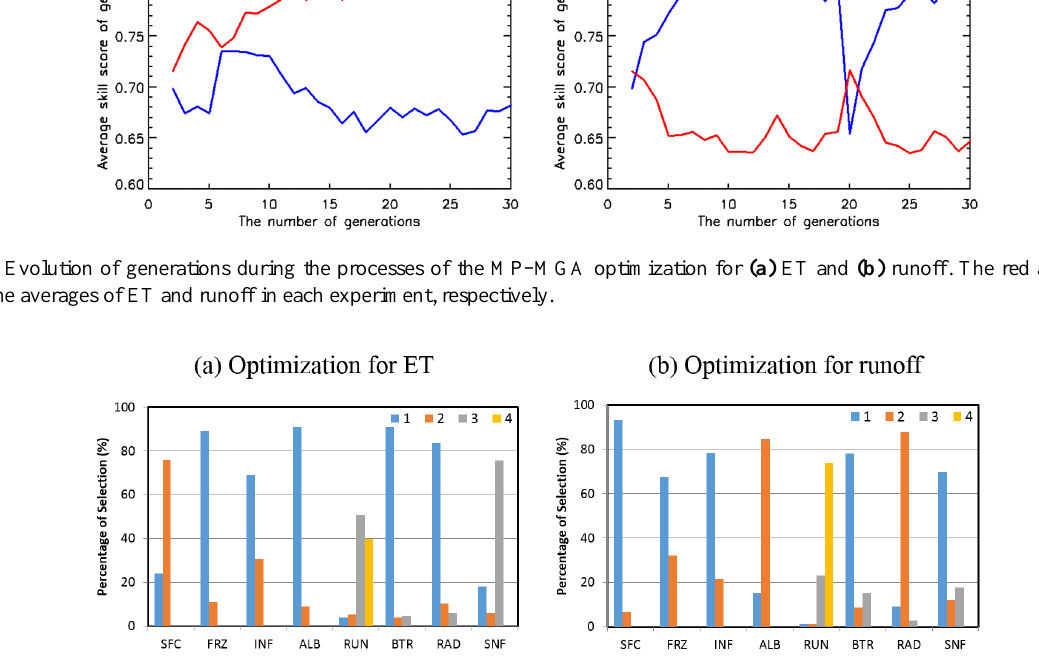
Figure 4. Percentage of selections of each scheme to the total number of simulations (300 simulations) from micro-GA during the entire optimization processes for (a) ET and (b) runoff. Each colour indicates the available options in each scheme